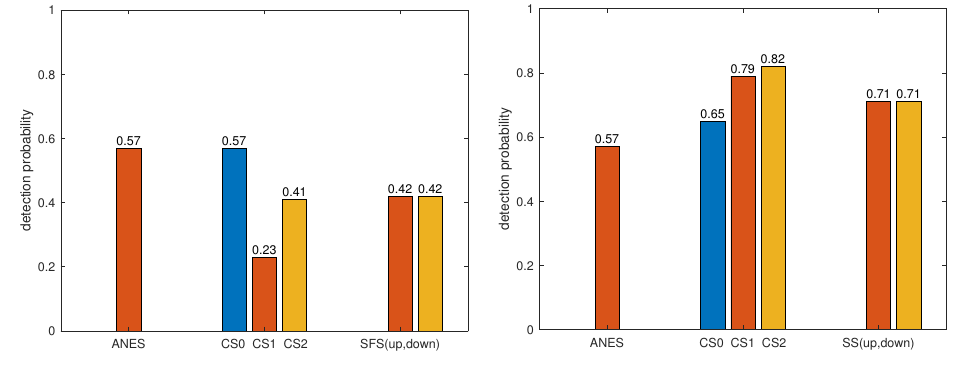
Figure 14. The quantization step of jamming power is 0.1.